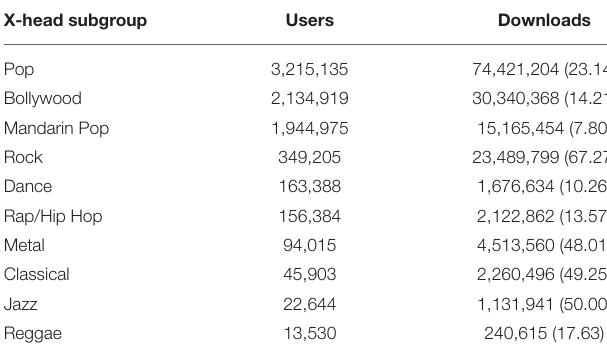
TABLE 1 | Descriptive statistics for X-head subgroups: number of users; number of downloads (average downloads per user). X-head